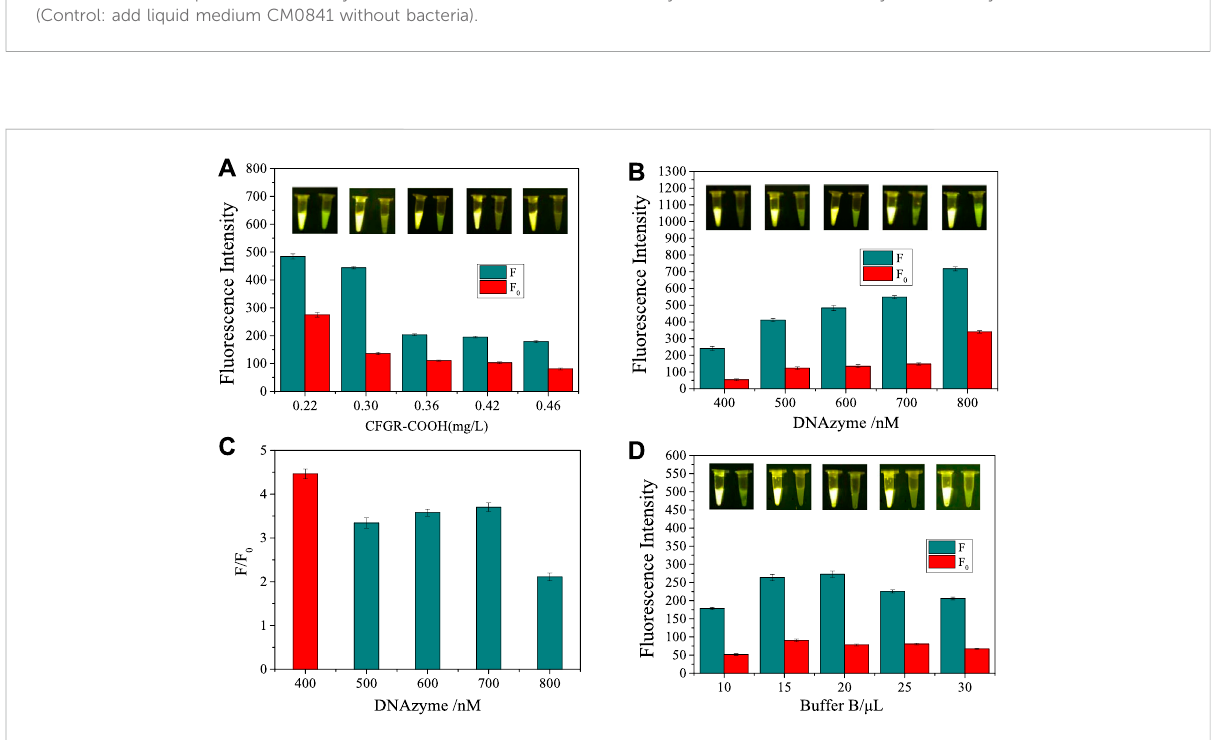
FIGURE 6 (A) Optimizationof CFGR andDNAzymebinding time. (B) OptimizationofDNAzyme content. (C) Theratio ofFto F 0 . (D) Optimization of Buffer Bcontent.(F: The fi nalvalueofthe fl uorescence intensity,F 0 :Theinitial valueofthe fl uorescence intensity,The insets of (A,B,D) show thereal-time fl uorescence changes in the